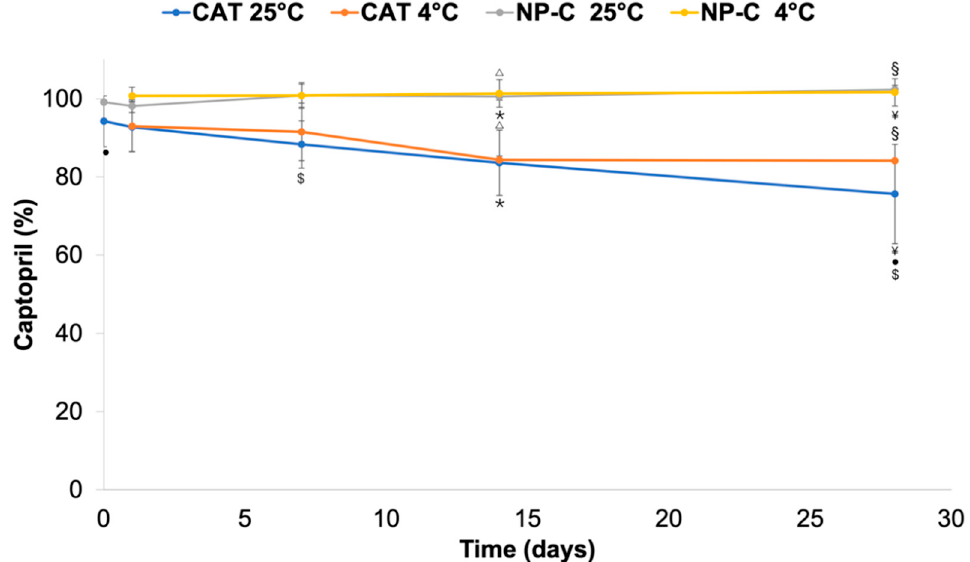
Figure 2. Chemical stability of CAT in aqueous solution (pH 3) and NP ‐ C over 28 days at 4° and 25 °C. * p value < 0.01: NP ‐ C day 14 at 25 °C vs. CAT day 14 at 25 °C. ¥ p value < 0.0001: NP ‐ C day 28 at 25 °C vs. CAT day 28 at 25 °C. Δ p value < 0.05: NP ‐ C day 14 at 4 °C vs. CAT day 14 at 4 °C. § p value < 0.01: NP ‐ C day 28 at 4 °C vs. CAT day 28 at 4 °C. • p value < 0.01: CAT day 0 vs. CAT day 28 at 25 °C. $ p value < 0.05: CAT day 1 vs. CAT day 28 at 25 °C.